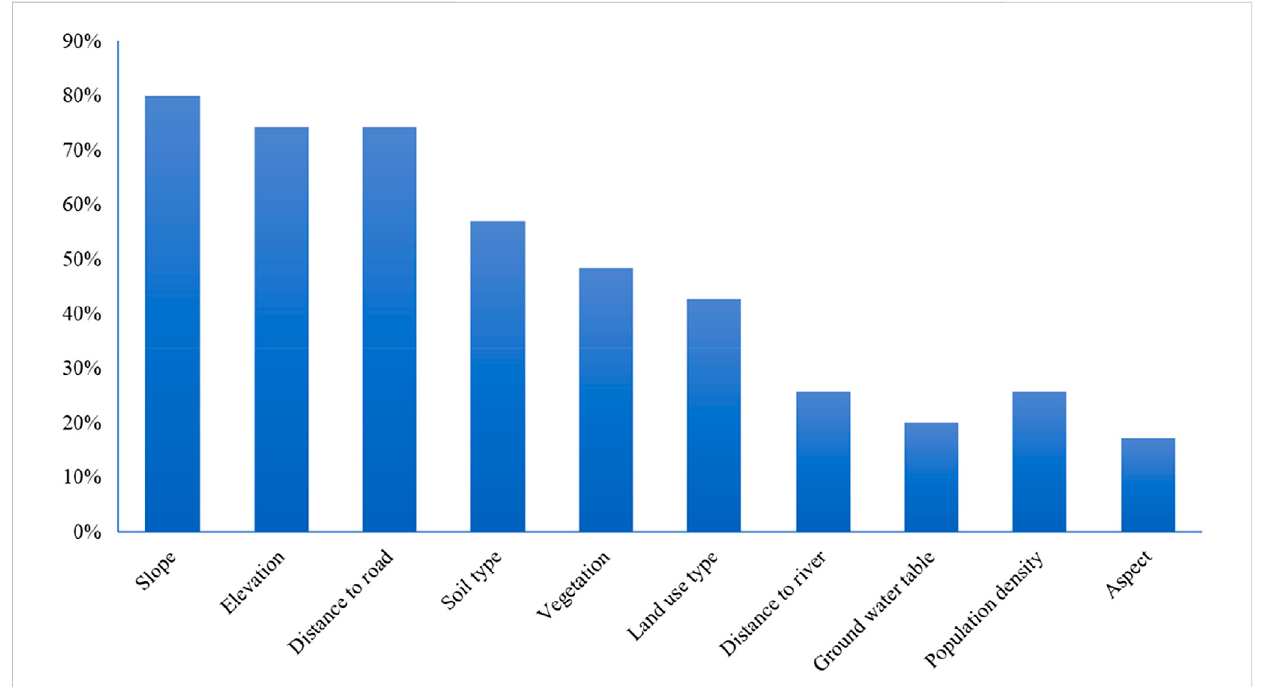
FIGURE 3 Frequency diagram of initial evaluation indices for construction land